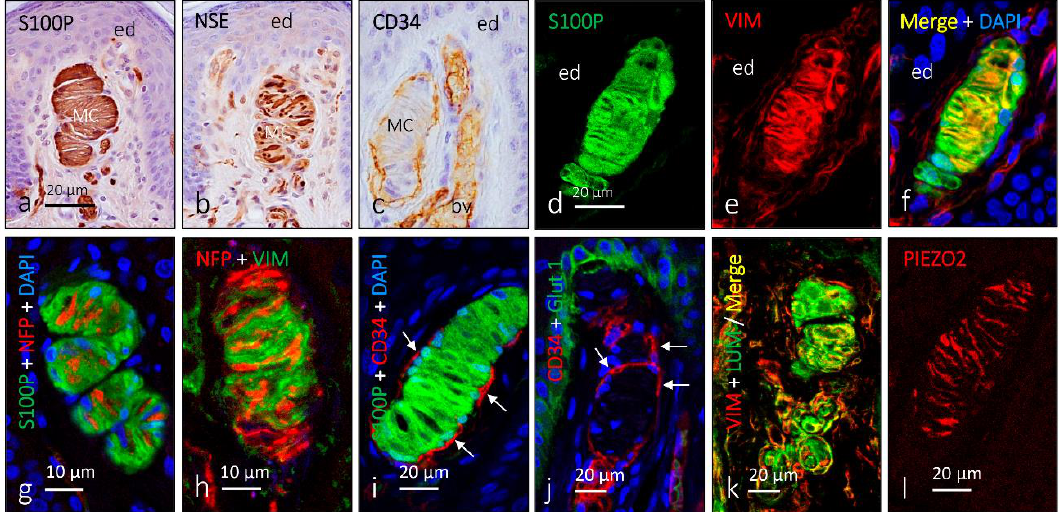
Figure 3 . Immunohistochemical profile of human cutaneous Meissner corpuscles. Immunohistochemical localization of S100 protein (S100), neuron-specific enolase (NSE), CD34, Glut-1, vimentin (VIM), neurofilament protein (NFP), lumican (LUM) and PIEZO2 in human digital Meissner corpuscles. ( a , b ) Serial sections of the same corpuscle showing the lamellar cells (S100-protein-positive) and the axon (NSE-positive); ( c ) immunolabeling of the endoneurial capsule (CD34-positive); ( d – f ) images of double immunofluorescence demonstrating that S100P and VIM colocalize in lamellar cells. ( g , h ) variable relationships of the axon (NFP-positive) with the lamellar cells (S100P- or VIM-positive); ( i , j ) endoneurial, but not perineurial, nature of the capsule in Meissner corpuscles (CD34-positive; arrows); ( k ) expression of lumican, a component of the extracellular matrix, in association with the lamellar cells; ( l ) expression of PIEZO2, a mechanoprotein involved in mechanotransduction in the axon of Meissner corpuscles. ed: epidermis; MC: Meissner corpuscles. bv: blood vessels (in c).